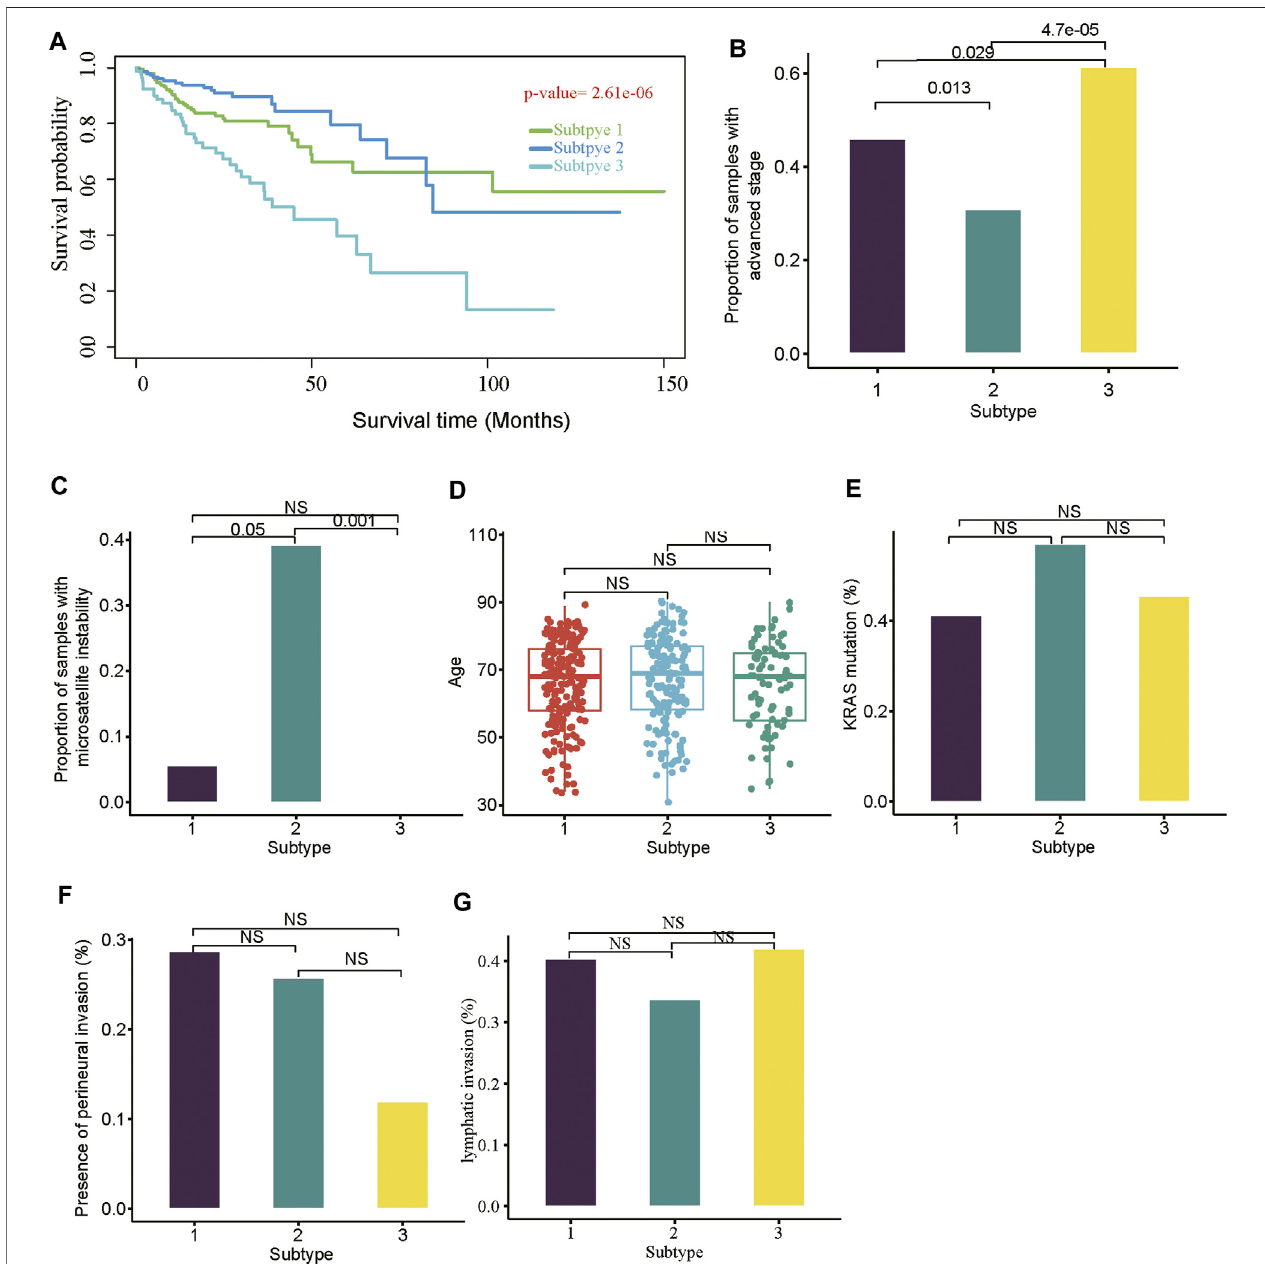
FIGURE3| Theassociationofsubtypes withtheclinicalcharacteristics. (A) Thedifferences ofoverallsurvivalamongthethree subtypes. Thepairwisecomparison between the three subtypes identi fi ed the differences of (B) COAD proportions with advanced stages (TNM stages III and IV), (C) proportion of samples with microsatellite instability (MSI), (D) age, (E) KRAS mutation frequency, (F) percentage of perineural invasion, and (G) percentage of lymphatic